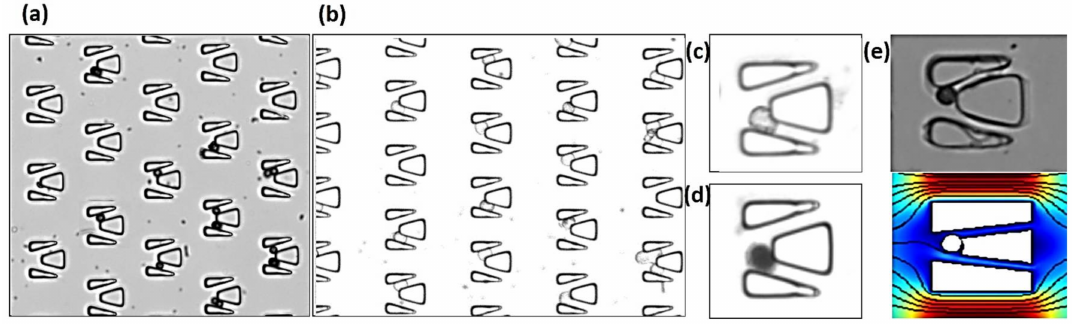
Figure 8. The cell-trap and drug testing results: ( a ) microspheres; ( b ) HeLa cells; ( c ) normal cell; ( d ) drug dosing; ( e ) comparison of experiment and simulation.